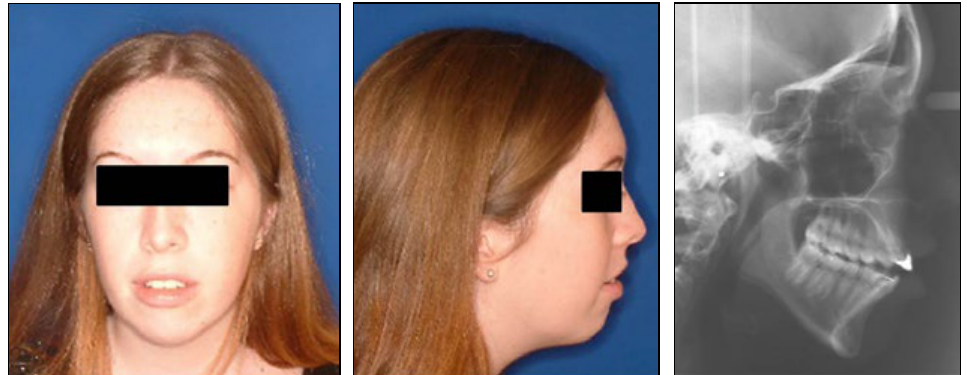
Figure 4. Pre-surgical photographs and cephalogram exemplifying a patient treated by anti-clockwise rotation of the occlusal plane during orthognathic surgery.